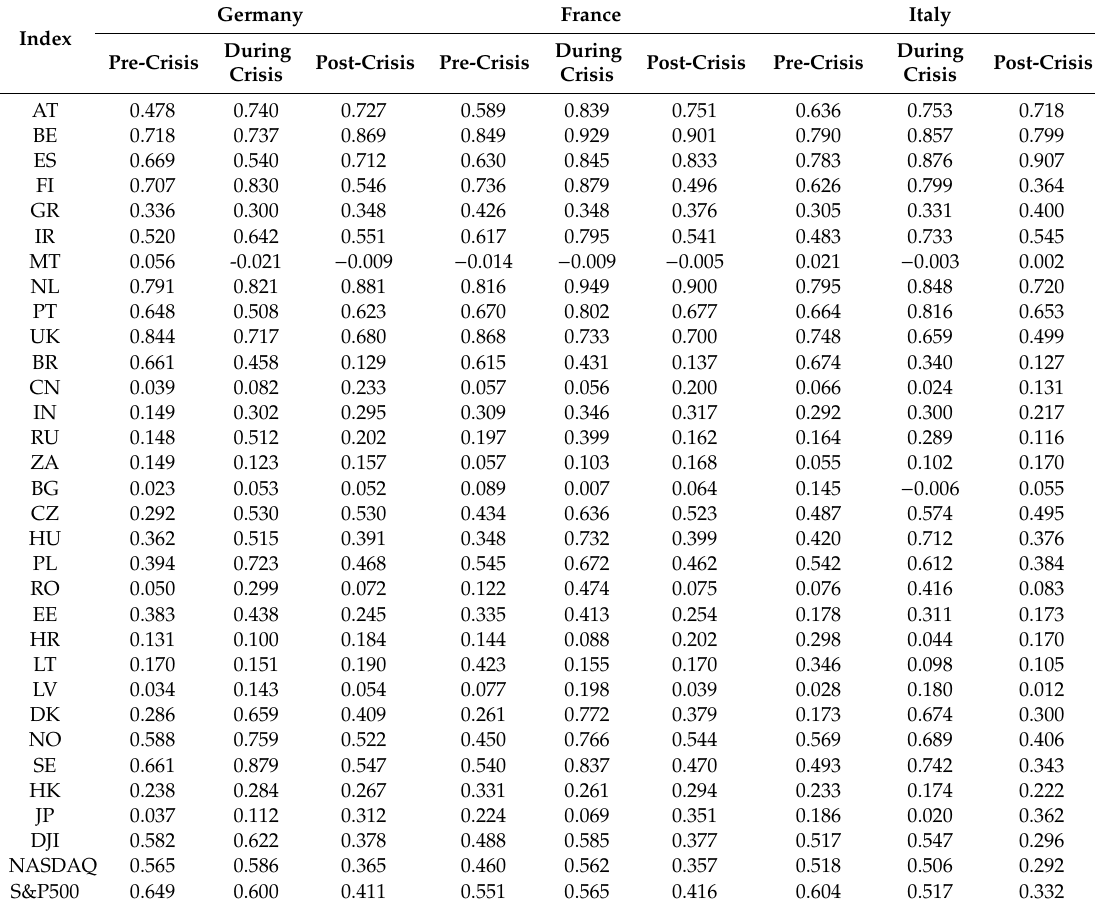
Table 2. Correlation coe ffi cients for squared stock index return for Pre-EZC, EZC and